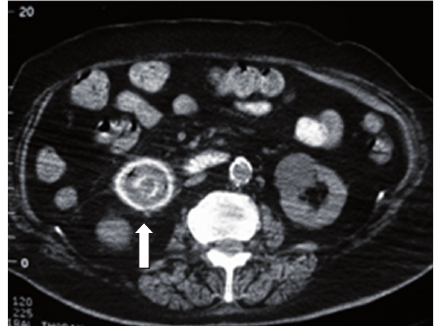
Figure 5: A gallstone in the 2nd to 3rd part of the duodenum (arrow).